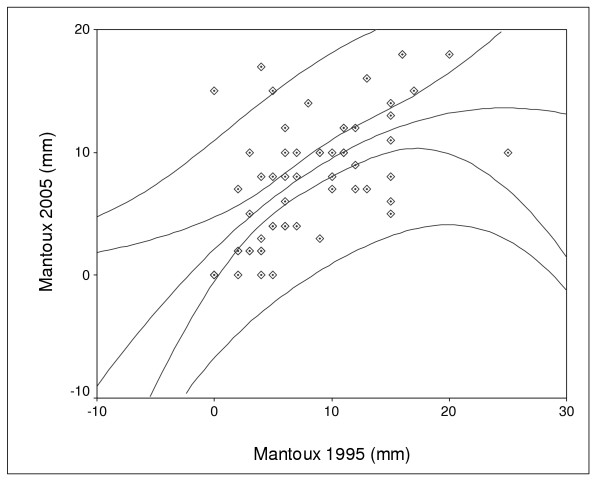
Paired sample correlation (quadratic regression) of tuberculin indurations between the two time – periods (initial study period and 10-year later follow up)